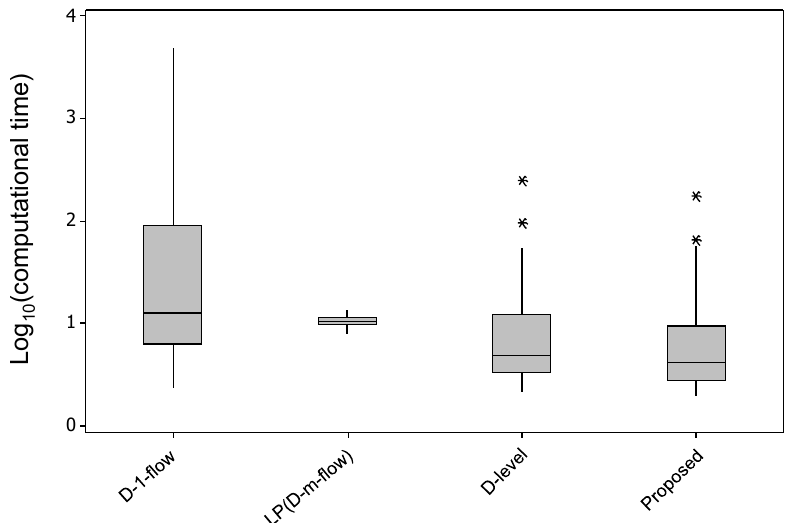
Figure 5. Box and Whisker plots for the distribution of computational times in seconds of selected models for the 40-node